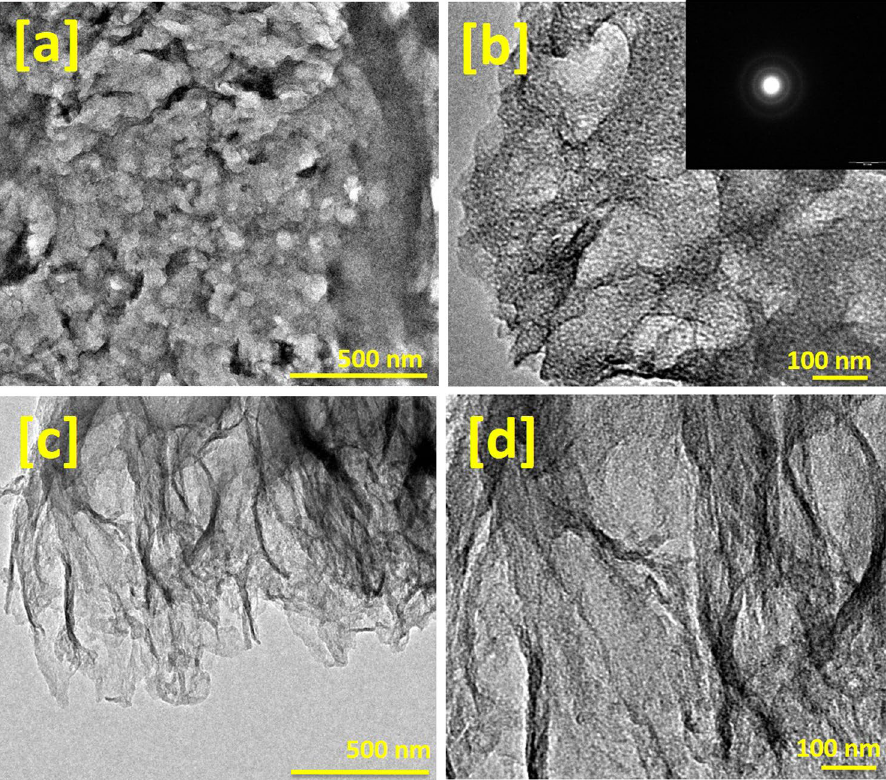
Figure 4. TEM images of the carbonized jute at various magnifications, ( a ) represents the porous microstructure, ( b ) further magnified version of figure ( a ); inset shows electron diffraction pattern of carbonized jute, ( c ) represents jute carbonized porous structure composed graphitic thin sheets, and ( d ) represents the magnified view of figure ( c ), where porosity of carbonized jute can be easily